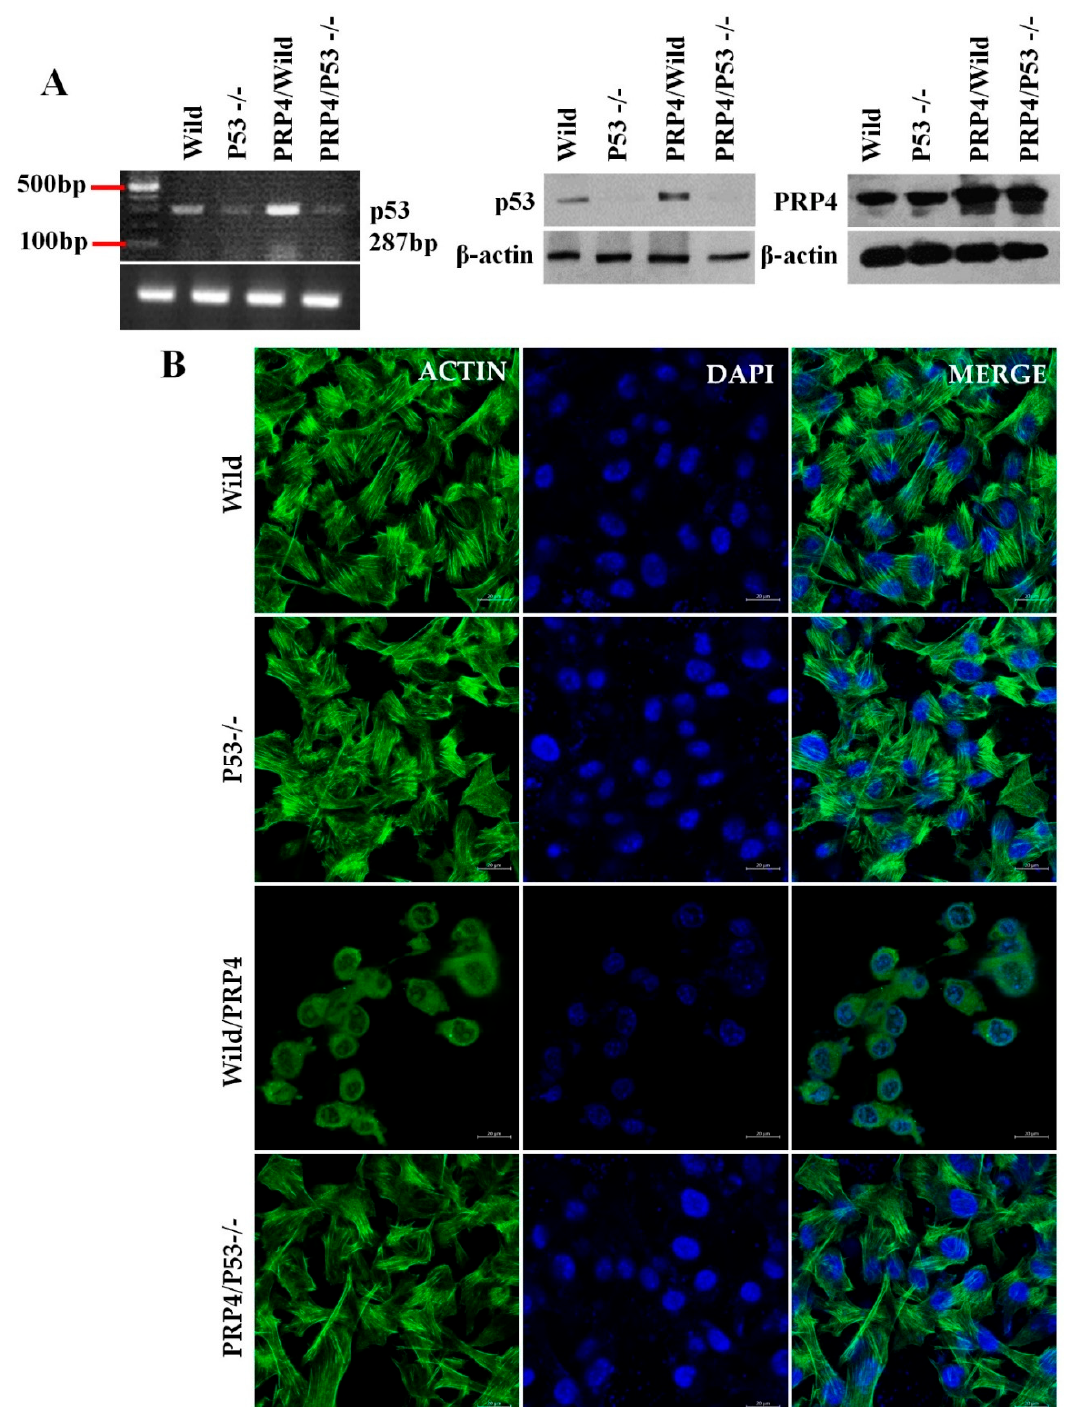
sue. Black arrowheads in the resveratrol-treated group indicate fragmented nuclei; ( D ) mouse tu- mor tissue extracts from control and treated groups were analyzed for expression of p53 and E- cadherin by Western blot and RT-PCR with actin and GAPDH as a loading control, respectively. * p < 0.05, ** p < 0.01, *** p < 0.001; ( E ) immunofluorescence microscopy of mouse tumor sections doc- umenting the expression of p53 and E-cadherin. Tissues sections are immunostained with anti-p53 and anti-E-cadherin antibodies. Nuclei are visualized by DAPI staining.